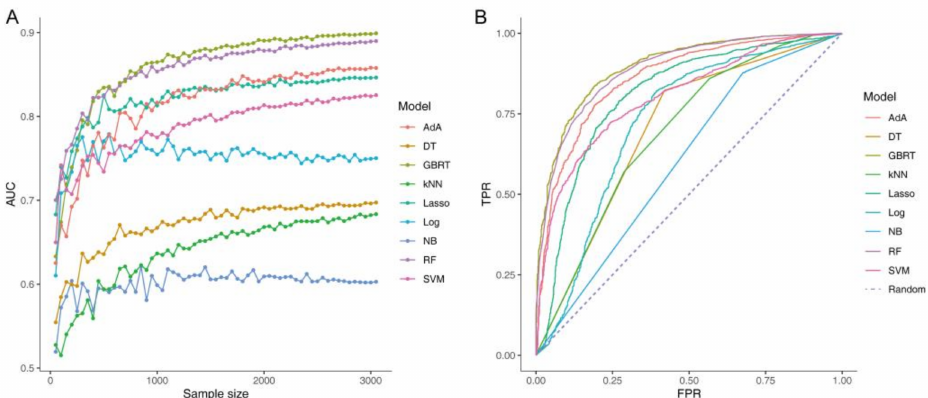
Figure 6. Association between the sample sizes and the area-under-the-curve values of the classifier models ( A ). The receiver operating characteristic curve of all of the models constructed based on the original datasets ( B